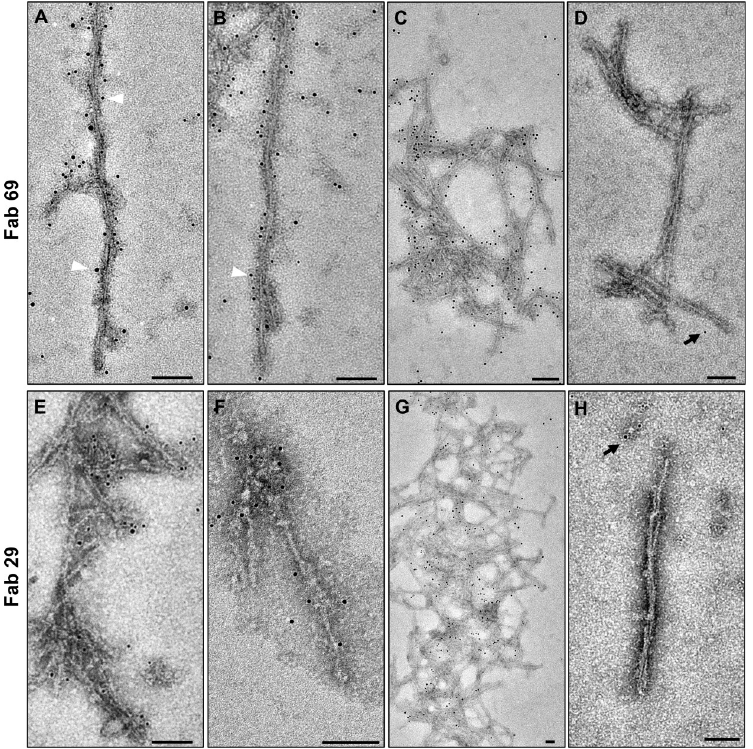
Fig 11. Immunogold electron microscopy of purified L-type BSE fibrils. Decoration of different fibrillar assemblies, including ( A ) two-protofilament, ( B ) one-protofilament, and ( C ) fibrillar aggregates, with Fab 69 and a 5 nm gold- conjugated ternary detection system. White arrowheads highlight a few gold particles along the fibrils. ( D ) Grids that were incubated without primary antibody showed only rare gold particles (black arrow), demonstrating the specificity of the Fab 69 labeling. Immunogold labeling of (E) two-protofilament, (F) one-protofilament, and (G) aggregates of L- type BSE fibrils with Fab 29 and a 5 nm gold-conjugated ternary detection system. ( H ) No specific labeling was observed in the grids with no primary antibody. Scale bar = 100